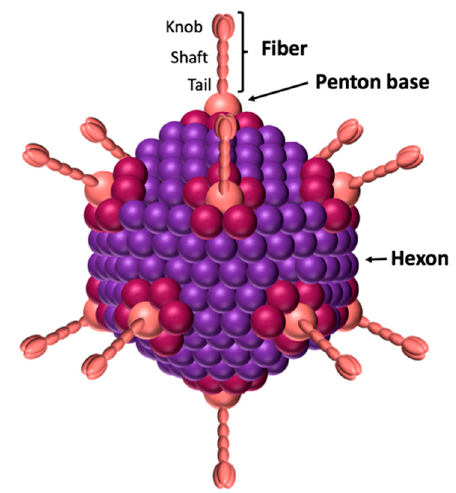
Figure 1. Schematic view of adenovirus. The icosahedral capsid is formed by the hexon. The penton base is located at the 12 vertices and forms a non-covalent complex with the trimeric fiber. The fiber’s knob domain is responsible for the interaction with the receptors.